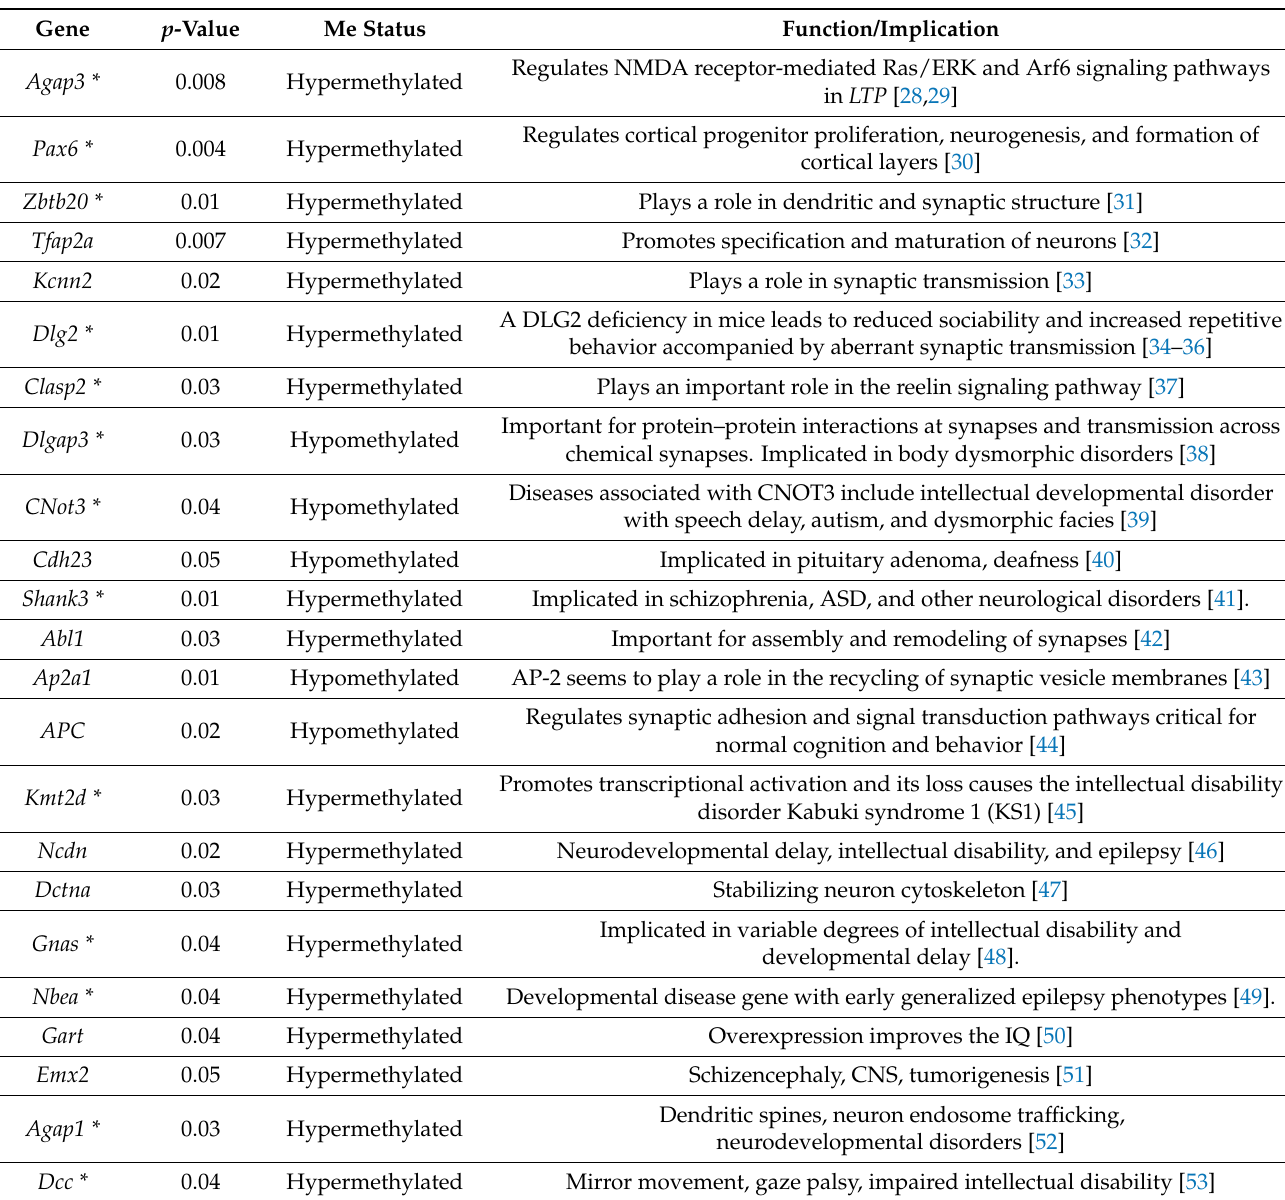
Table 1. List of differentially methylated genes involved in several neurological functions. The genes labeled with * are the ones associated with ASD and listed in the SFARI